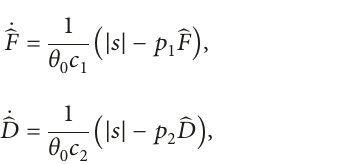
Figure 6: Time response of the sliding variable s under the initial value ( ii )